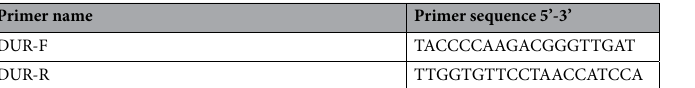
Table 6. The primer sequences designed from nadh A gene used for the validation of the biosensor performance of 27 MK